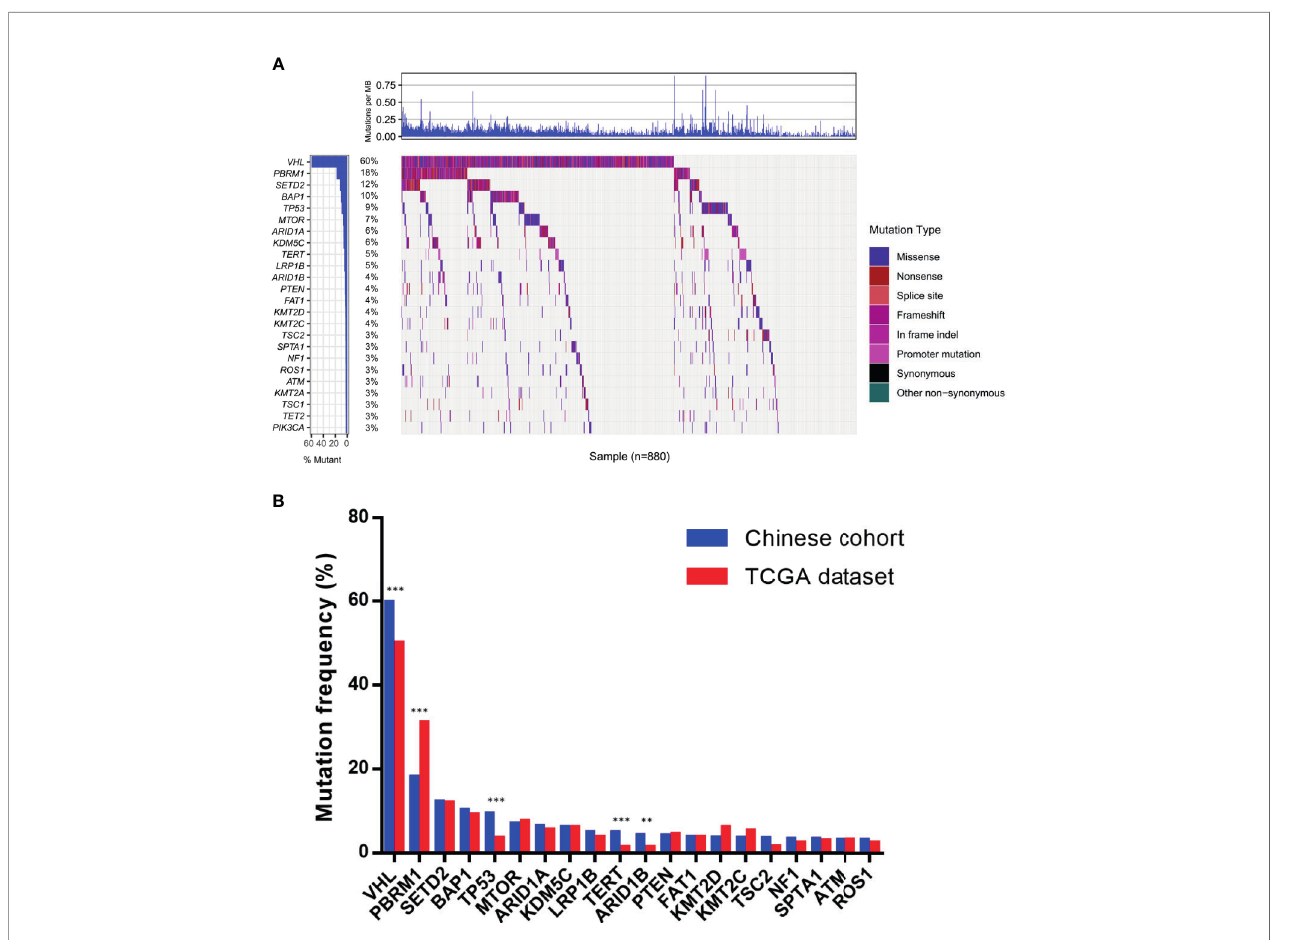
FIGURE 1 | Molecular features of Chinese clear cell renal carcinoma. (A) The somatic mutation landscape in Chinese clear cell renal carcinoma patients. (B) Discrepancies of mutation frequency between Chinese cohort and TCGA dataset. **p < 0.01, ***p < 0.001. TCGA, The Cancer Genome Atlas.